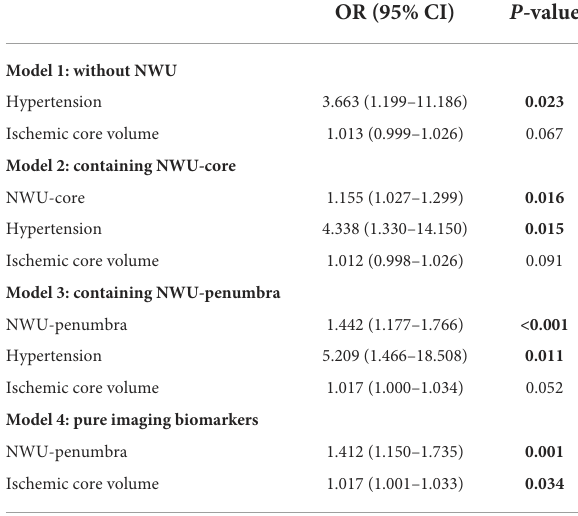
TABLE 3 Multivariable logistic regression analysis for predictive models of sICH in patients with